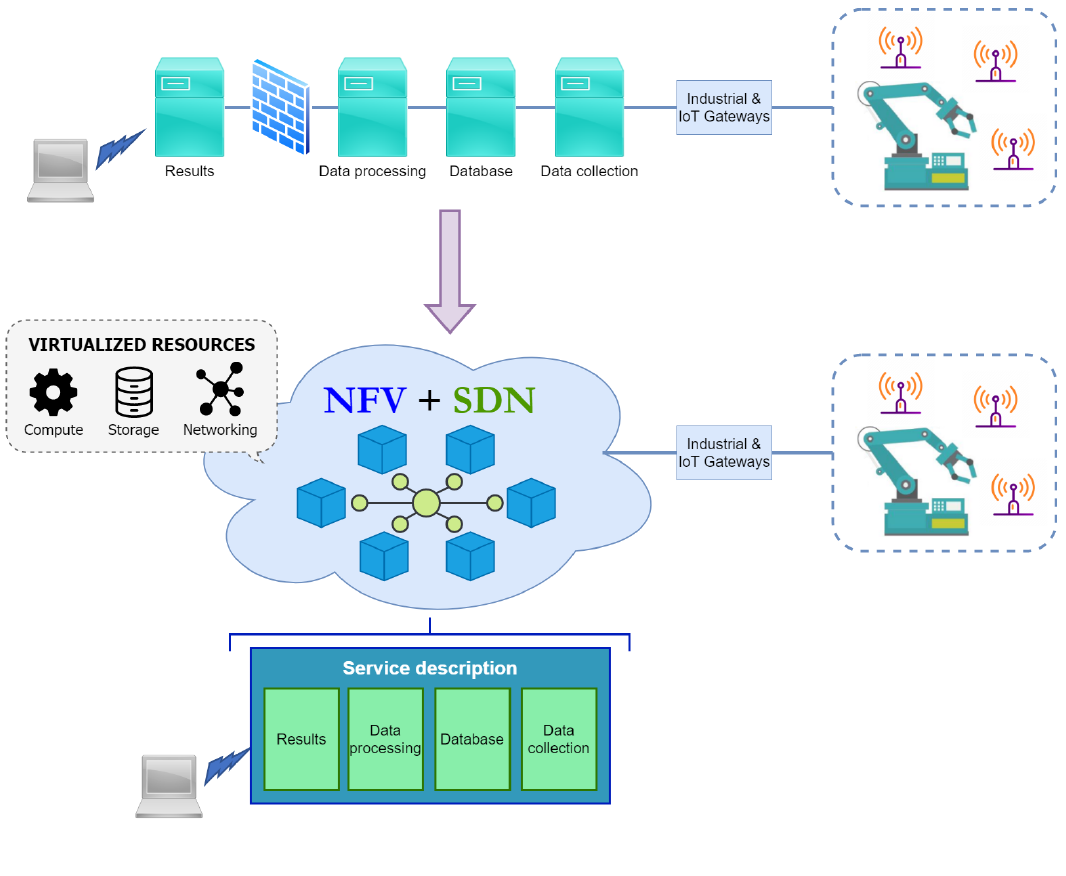
Figure 1. Integration of Industry 4.0 with Network Functions Virtualization (NFV) and Software-Defined Networking